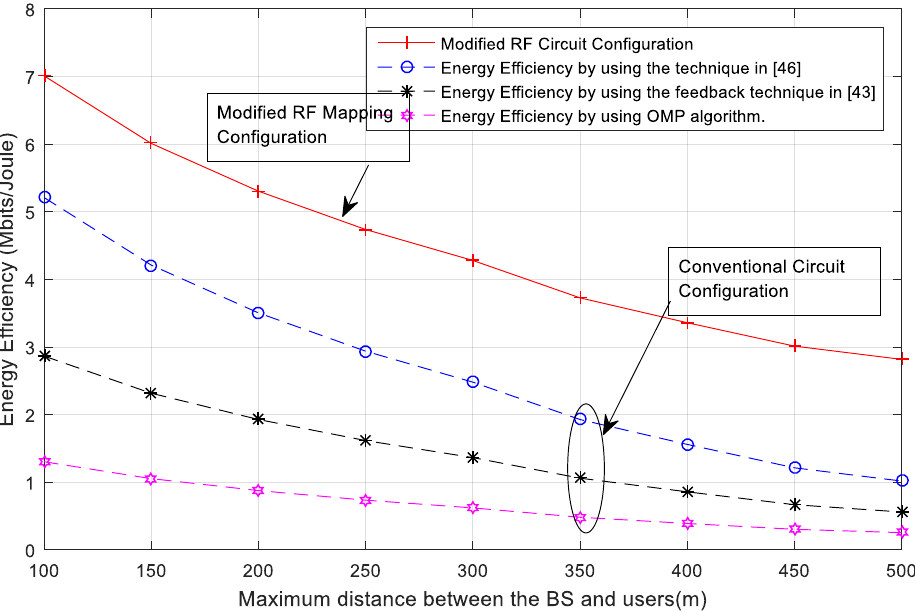
ffi ciency computed by using di ff erent algorithms. Figure 7. Comparison of the Energy Efficiency computed by using different algorithms. Figure 7. Comparison of the Energy E